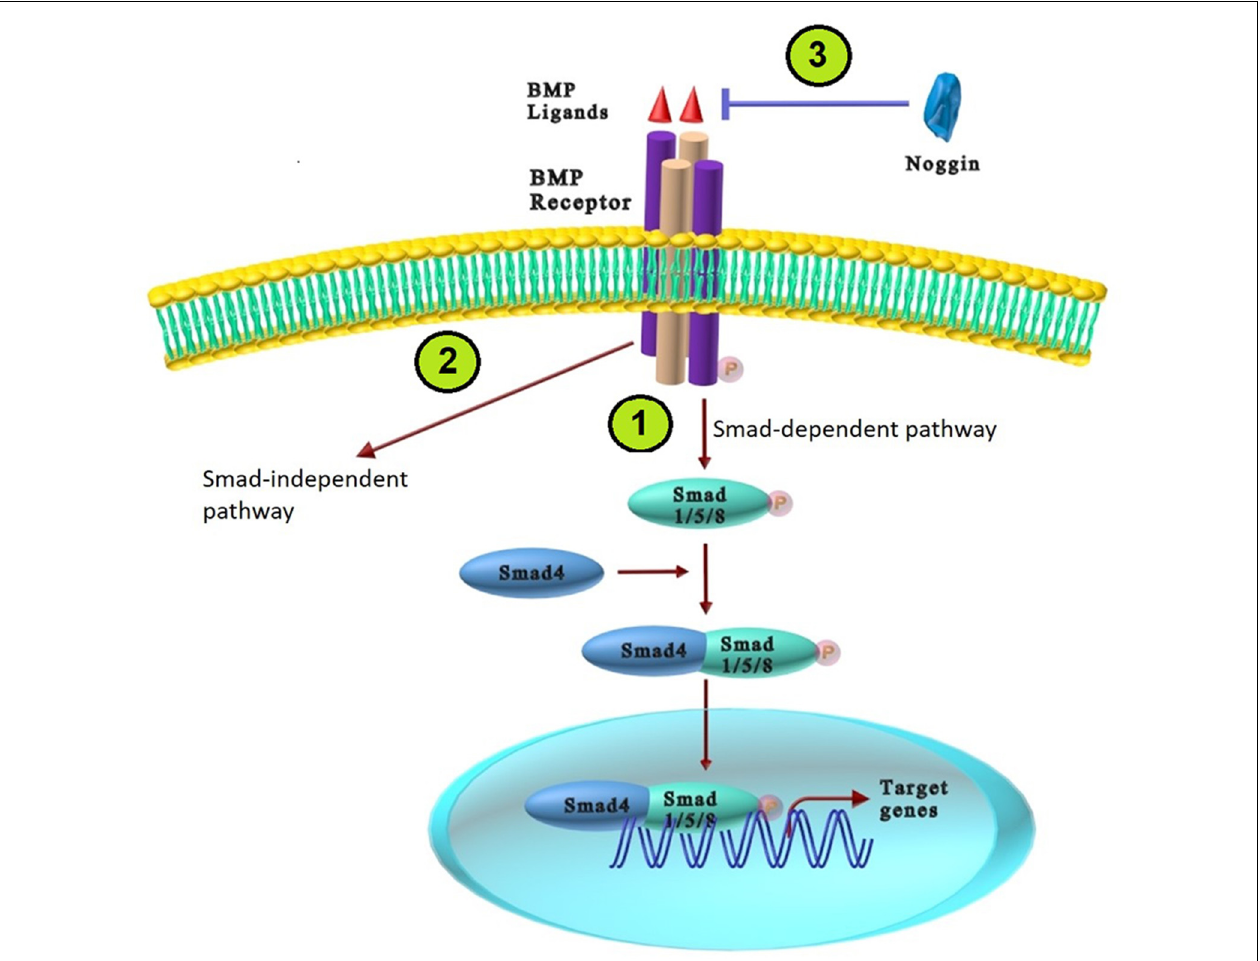
FIGURE 1 | The BMP signaling pathways. (1) The BMP Smad-dependent (canonical) pathway: BMPs bind type II receptor and constitutively active type I receptor, which trans-phosphorylate and activate Smad1/5/8 (R-Smads). Phosphorylated Smad1/5/8 binds with Smad4, which translocate to the nucleus and regulate BMP downstream target genes. (2) The BMP Smad-independent (non-canonical) pathway: BMPs ligands activate the non-canonical pathway through TAK1, MKK3, and p38 mitogen activated protein kinase (MAPK). (3) BMP antagonists (Noggin) bind to BMPs ligands and prevent BPMs from binding to their